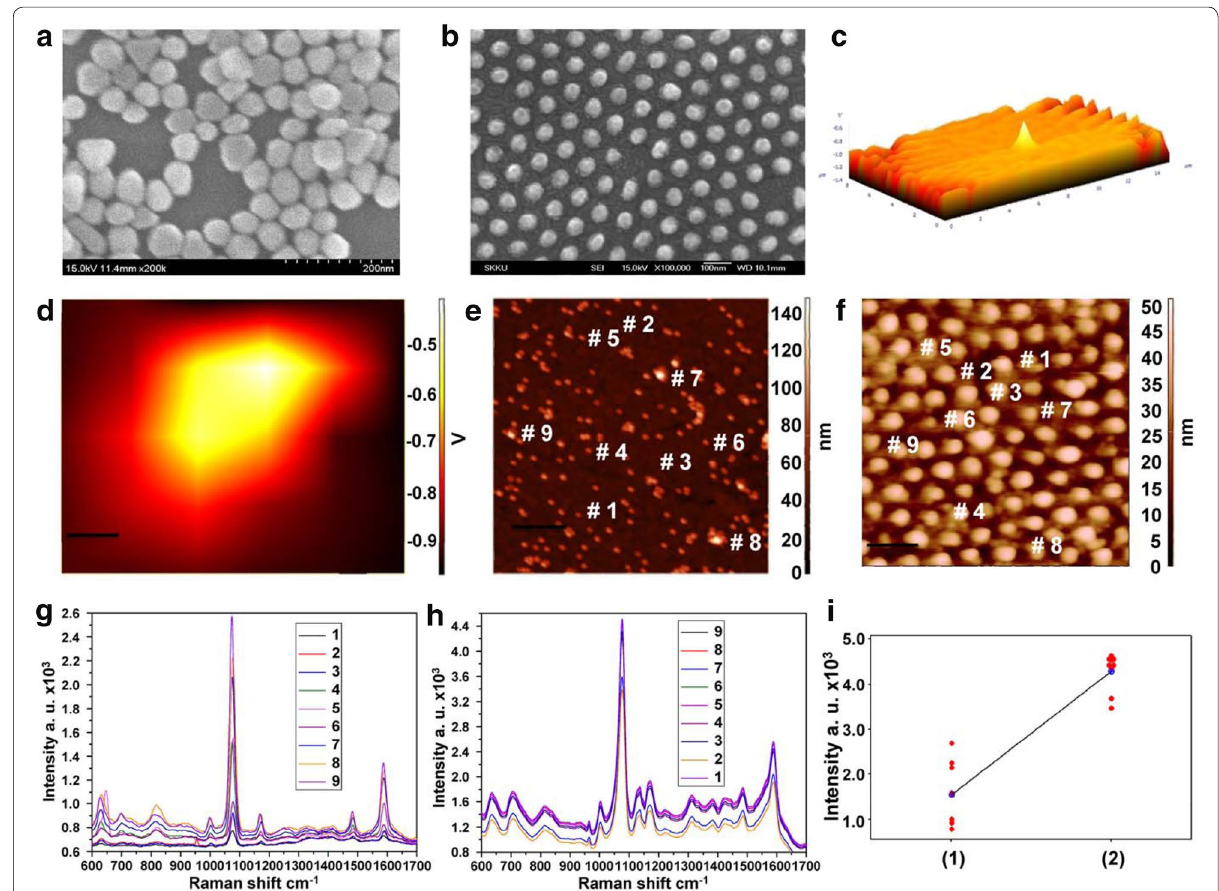
Fig. 8 Characterization of the SERS‑active substrates. a SEM topography of Au NPs deposited on the APTMS/ITO substrate. b SEM topography of the Au nanodot array fabricated on an ITO surface through an Al mask. c Three‑dimensional confocal image of the AFM tip. d Confocal image of the AFM tip focused at the same point as the IR laser. e AFM topography of the PATP/Au NPs deposited on the APTMS/ITO substrate. f AFM topography of the PATP/Au nanodot array fabricated on an ITO surface. g SERS spectra of PATP at several points from the Au NP array substrate. h SERS spectra of PATP at several points from the Au nanodot array substrate. i Intensity distributions of the Raman peak corresponding to NH group within the SERS intensity peaks recorded from the PATP monolayer immobilized on the (1) Au NP array and (2) Au nanodot array (Reprinted from [96]. Copyright